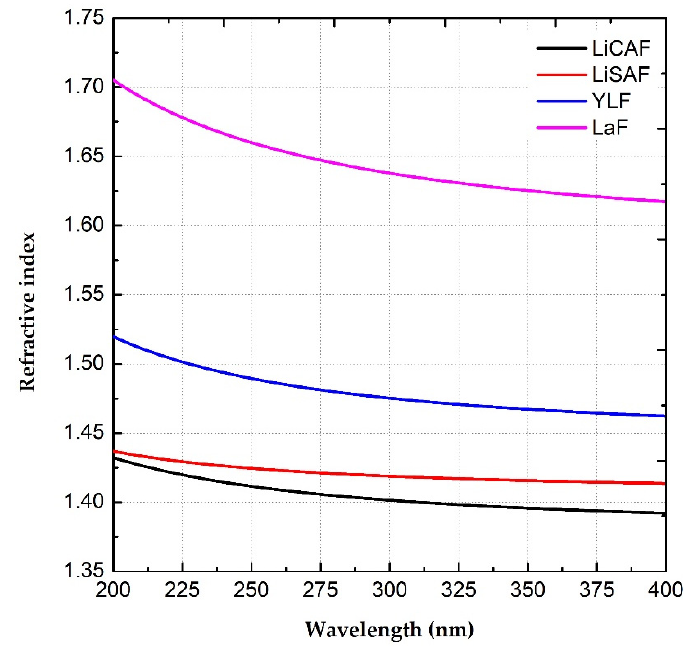
Figure 1. Linear refractive index ( n 0 ) of the fluoride laser materials.